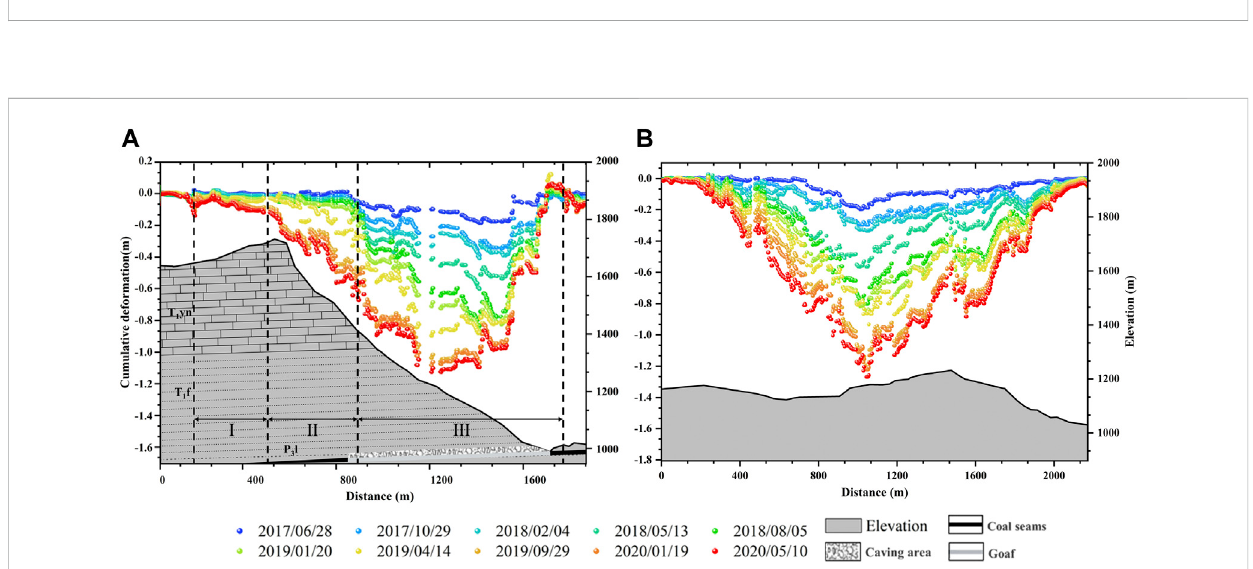
FIGURE 11 Line-of-sight deformation time series obtained from ALOS/PALSAR-2 data along pro fi les AA ’ and BB ’ . (A) LOS deformation time series along pro fi le AA ’ ; (B) LOS deformation time series along pro fi le BB ’ . The grey area is the topography pro fi le from ALOS DSM. The location of pro fi les is shown in Figure